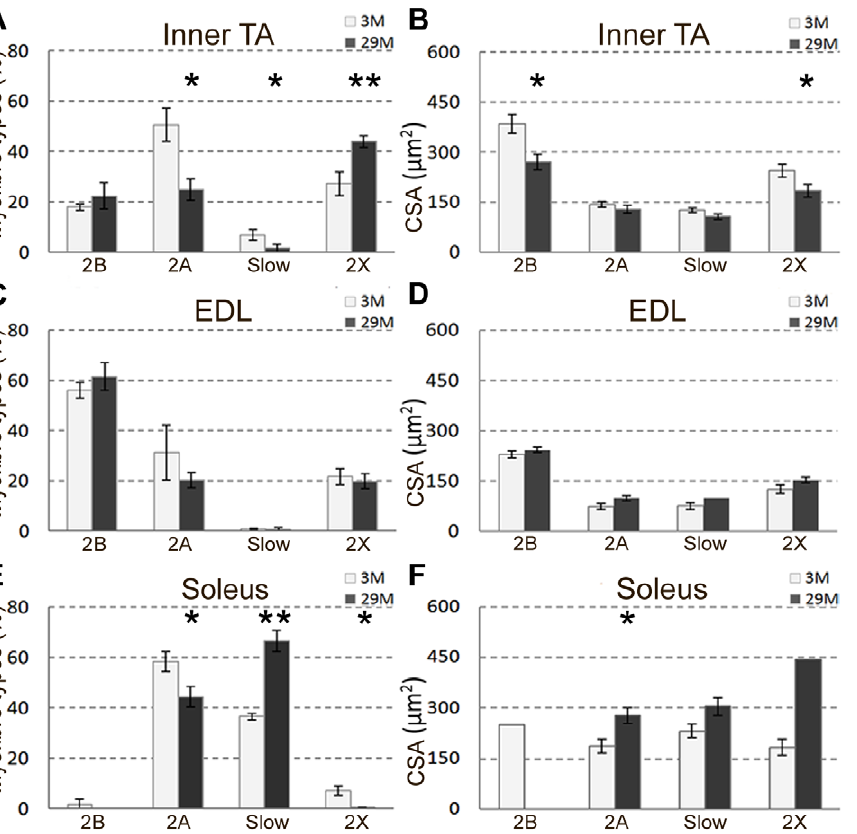
Figure 7. Percentage (A,C,E) and average cross-sectional area (B,D,F) of different myofibre types in the TA, EDL and soleus muscles of 3 and 29 month old mice. There are no error bars on some of the graphs (D,F) as the myofibre types were present in less than 3 animals (i.e. variation in myofibre type distribution occurred in different animals within the same age group). N=4 animals per age group. *P , 0.05, **P , 0.005. Values are mean 6